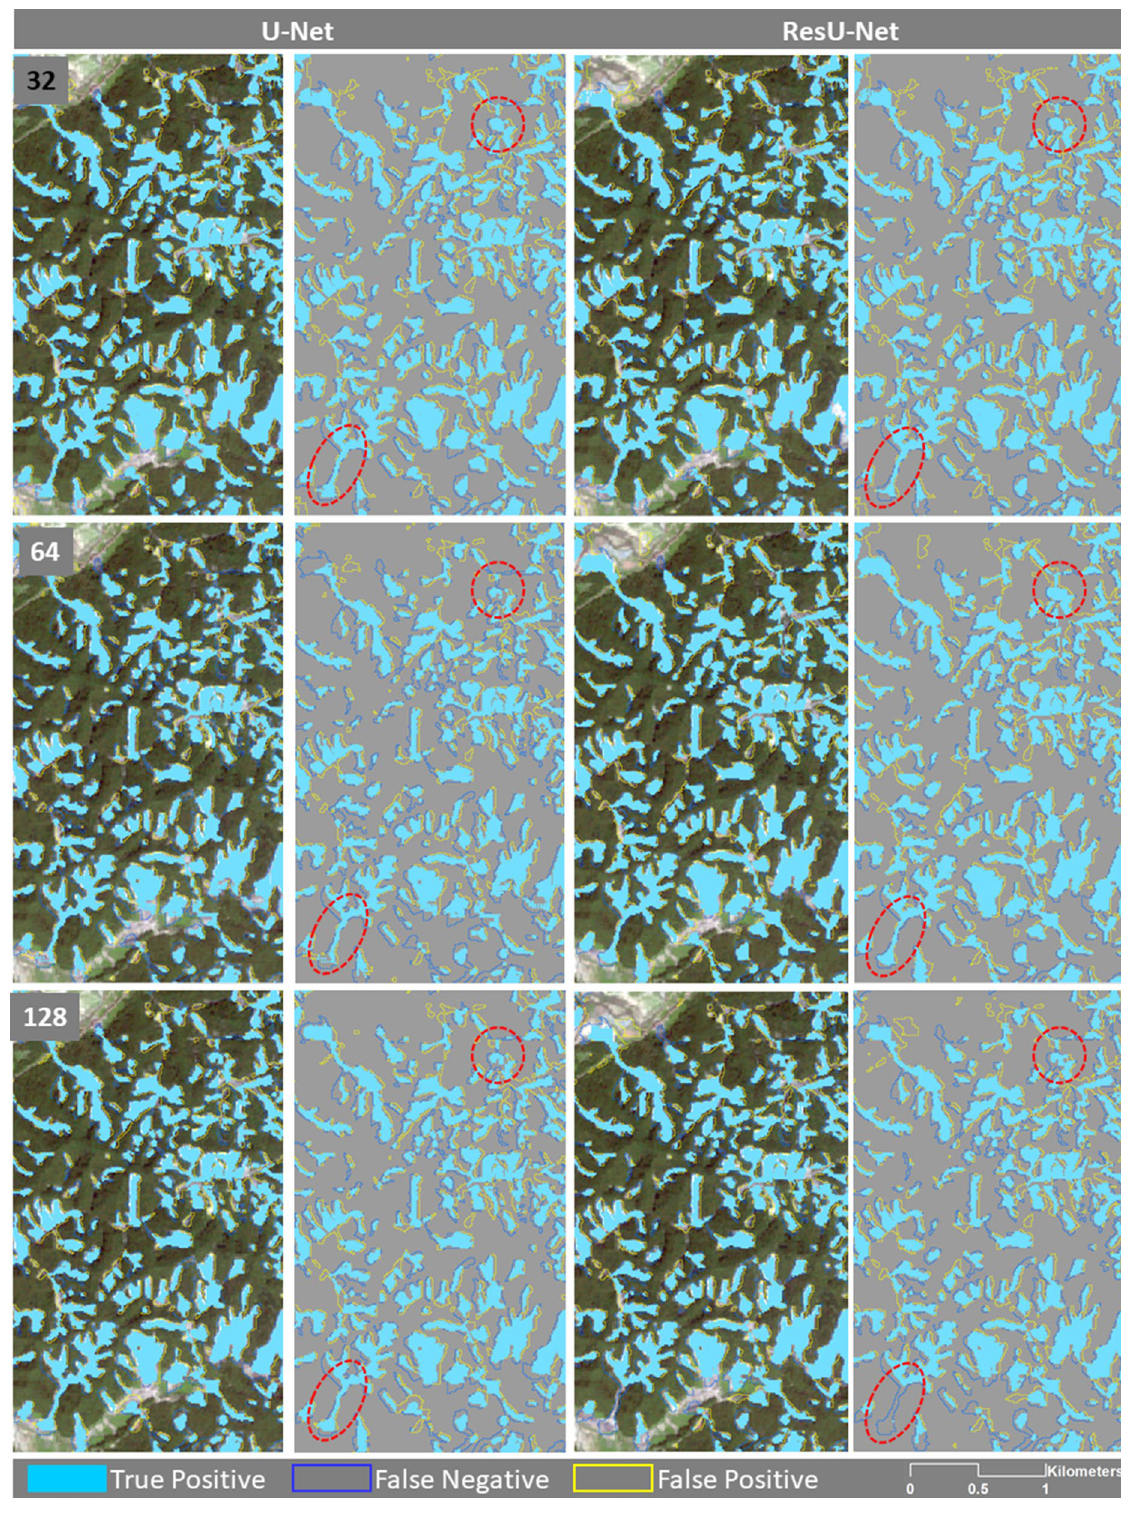
Figure 9. The enlarged areas of the results of the U-Net and ResU-Net trained and tested on the Japan datasets using different sample patch sizes. Red ovals showing examples of differences in the results. The maps were created using Python 3.6 (https:// www. python. org/) and the ArcMap v.10.8 software (https:// deskt op. arcgis. com/ es/